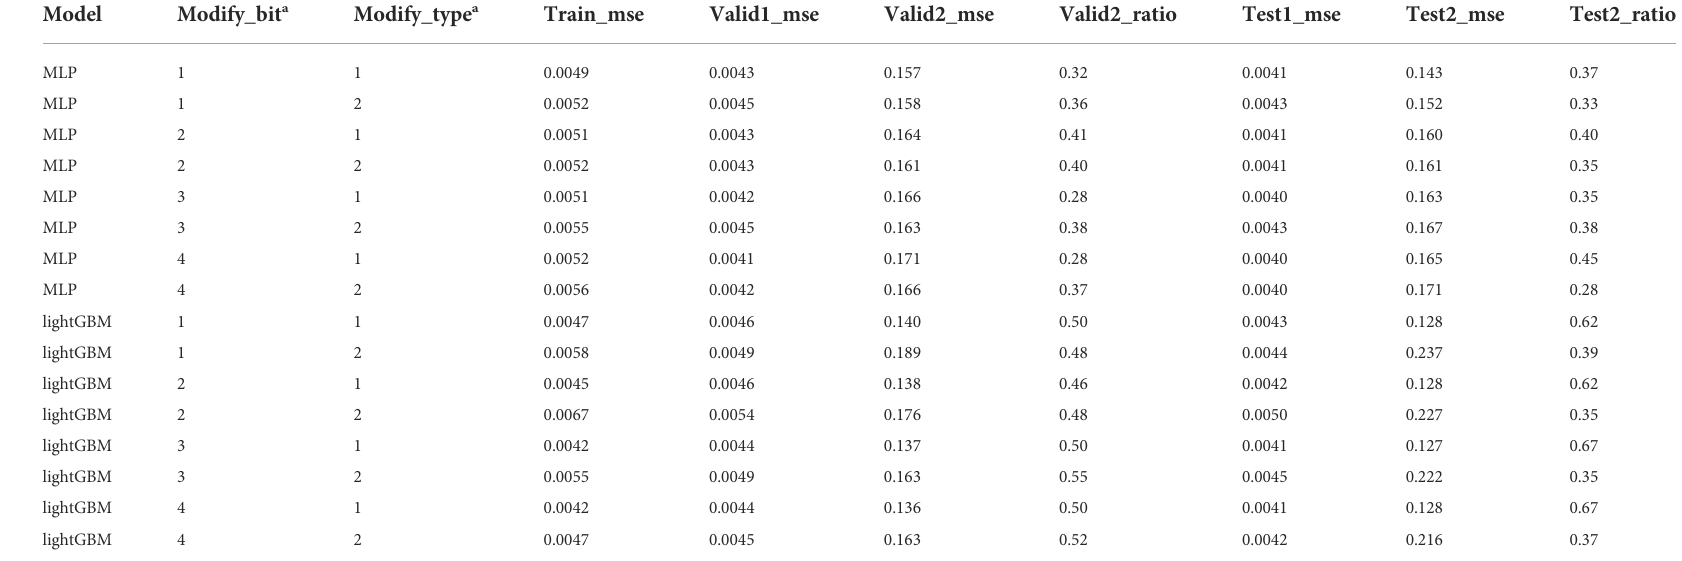
TABLE 3 The average result obtained by randomly setting the value of bit 0 on 1 – 4 molecular fi ngerprints to 1 and repeating ten times.